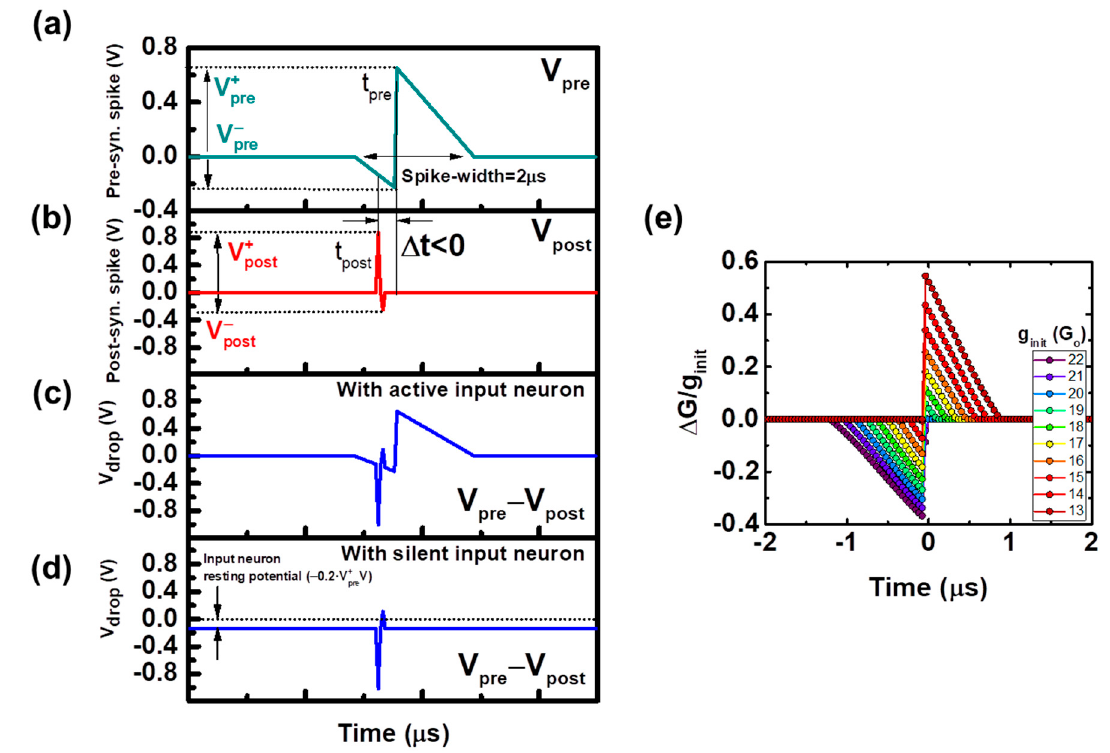
Figure 8. Pair of proposed pre ( a ) and post-synaptic ( b ) waveforms. Resulting voltage drop waveform applied to the sample for an active ( c ) and silent ( d ) pre-synaptic (input) neuron. ( e ) Balanced STDP function. Each curve corresponds to a different initial conductivity state of the same device.